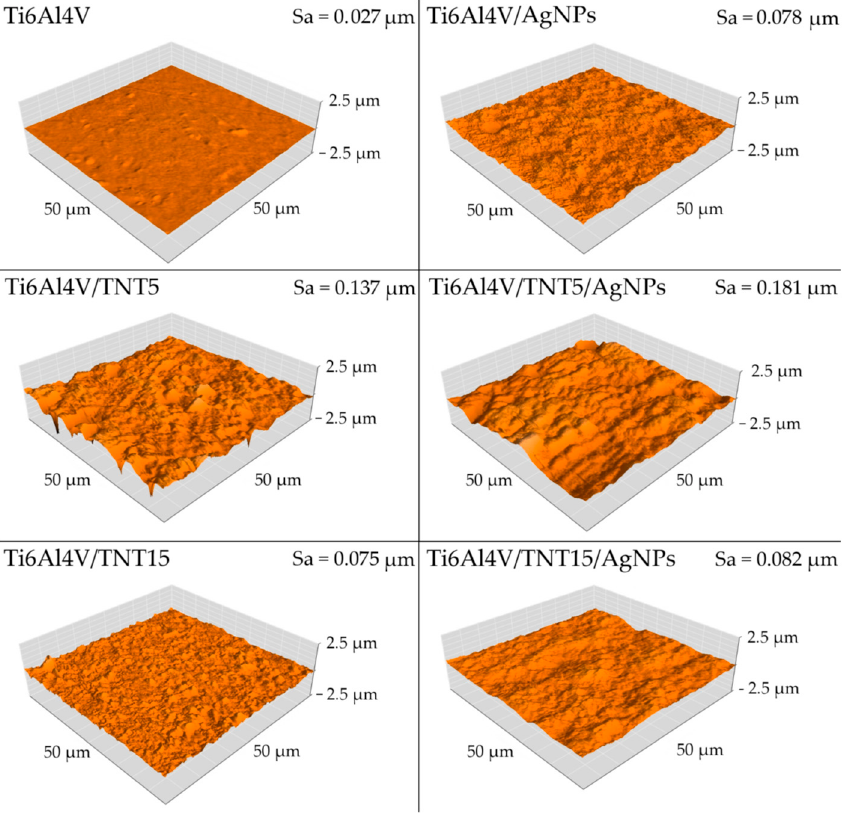
Figure 5. Atomic force microscopy (AFM) surface topography and S a parameter of reference Ti6Al4V, Ti6Al4V/AgNPs, and Ti6Al4V/TNT/AgNPs composites.